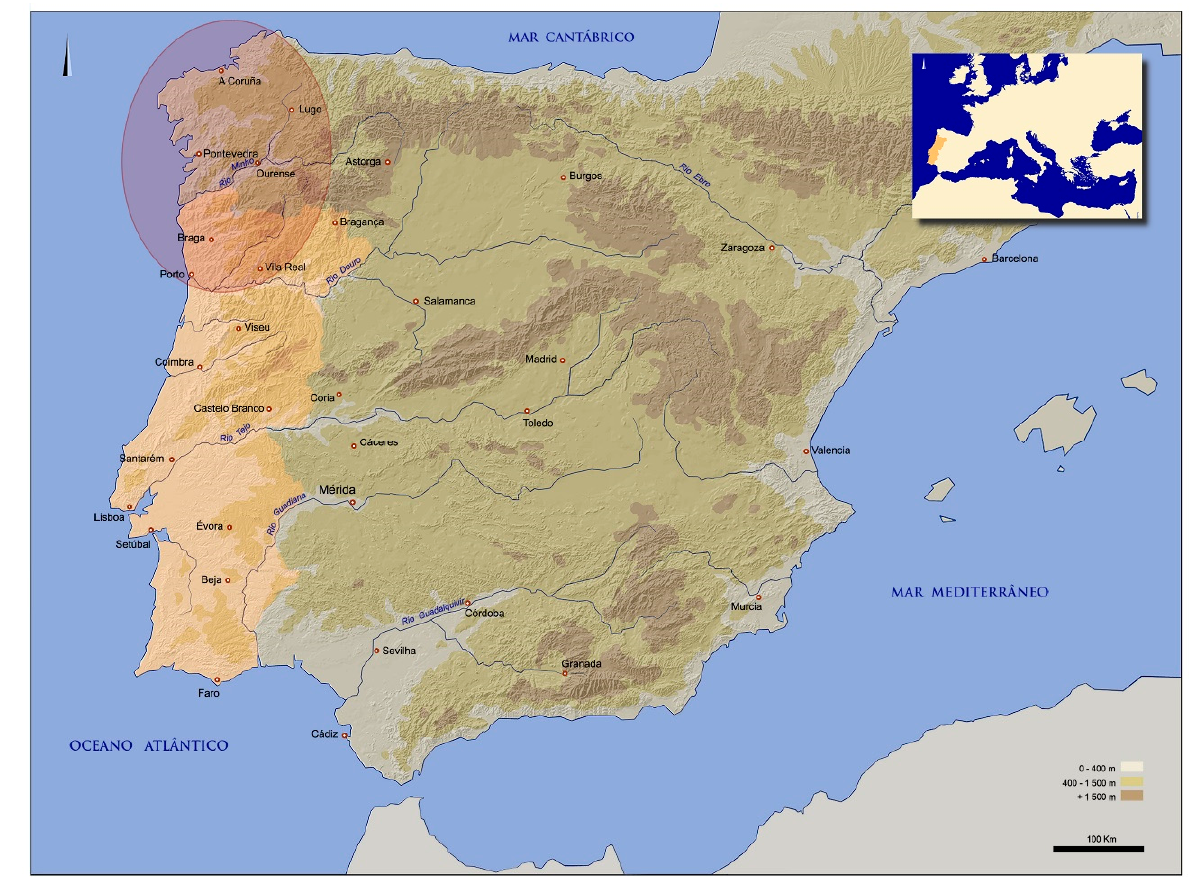
Figure 1. The distribution area of WHR vessels in the context of the Iberian Peninsula based on information from Nonat et al. [17] (image authored by José Luís Madeira).